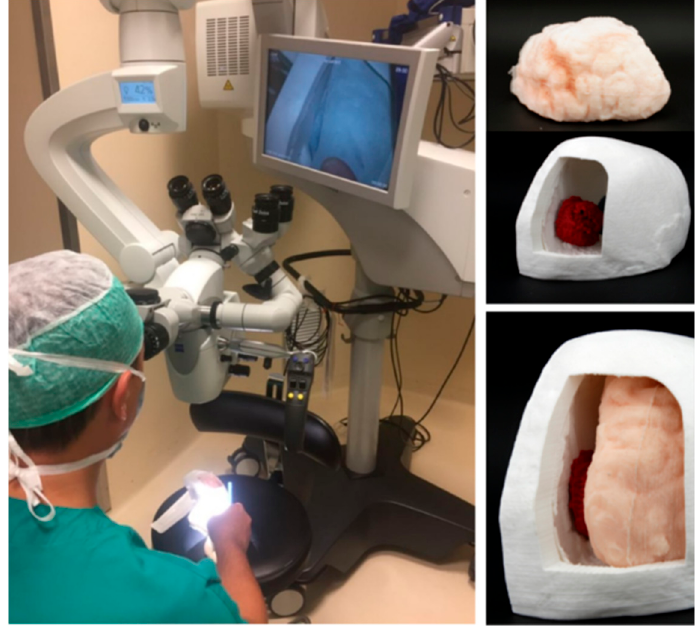
Figure 4. A biomodel which consists of a skull, brain, and tumor growth. A neurosurgical microscope